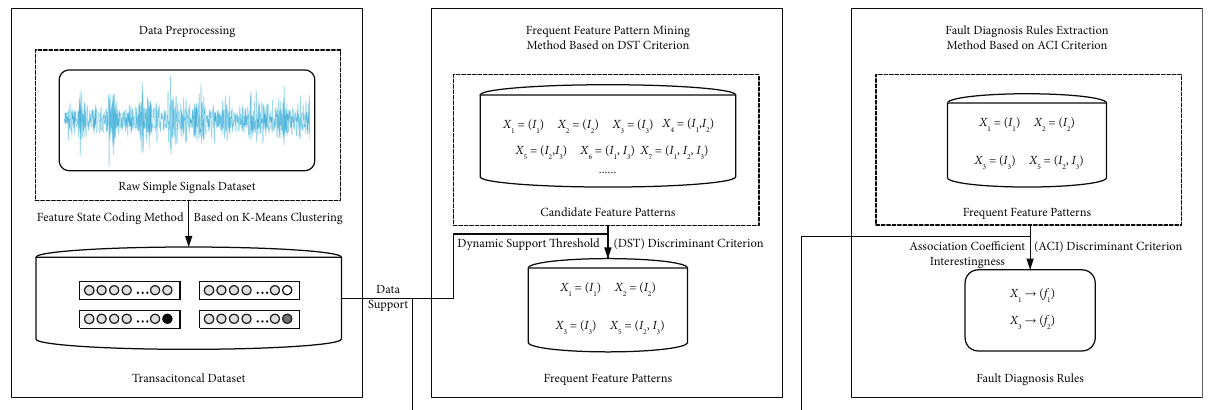
Figure 1: The logical and technical relationship between the main innovations.